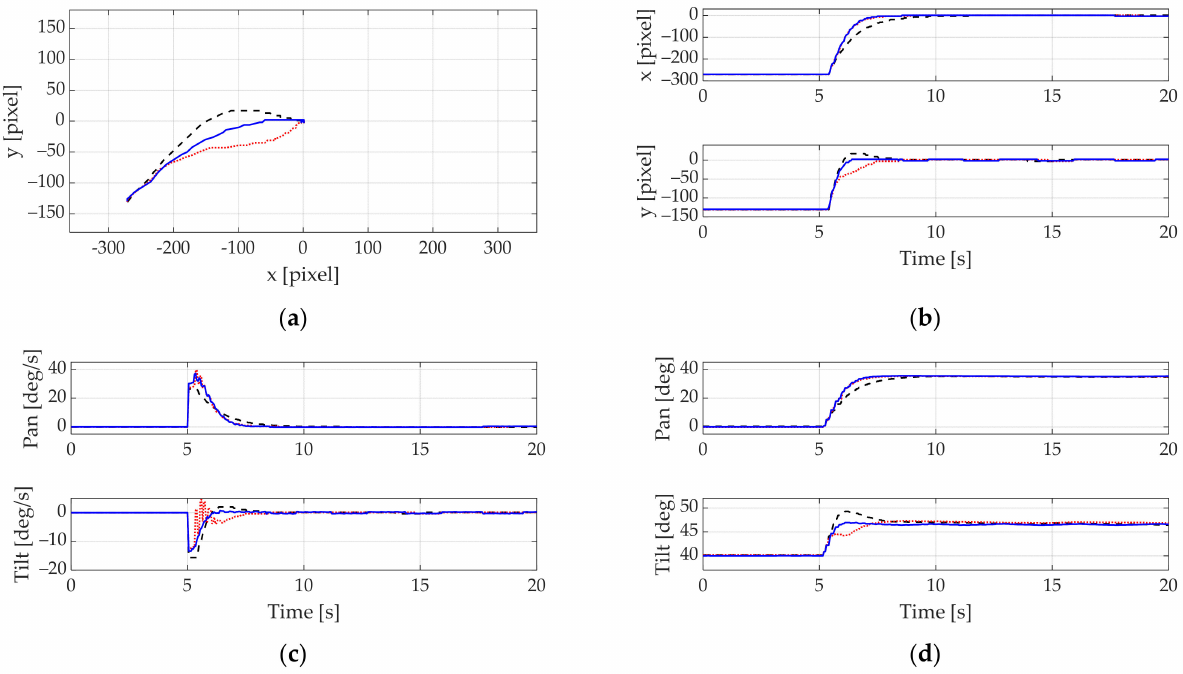
Figure 9. Experiment 2: Tracking a target point on the bottom-left corner of the image plane. ( a ) Tracking path on the image plane; ( b ) time response of each coordinate; ( c ) control signals; ( d ) orientations of the inner